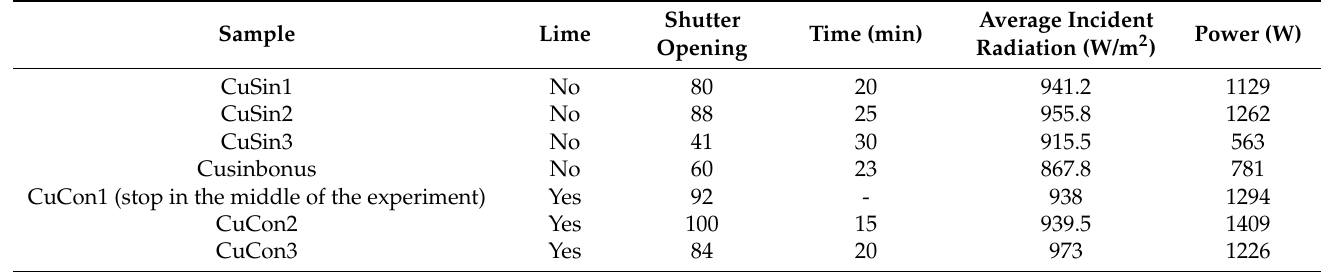
Table 3. Conditions used in the